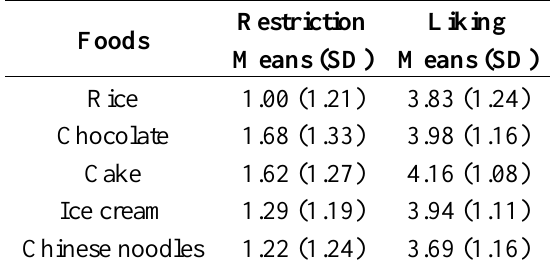
Table 2. Means (SD) of the five items with the highest mean craving